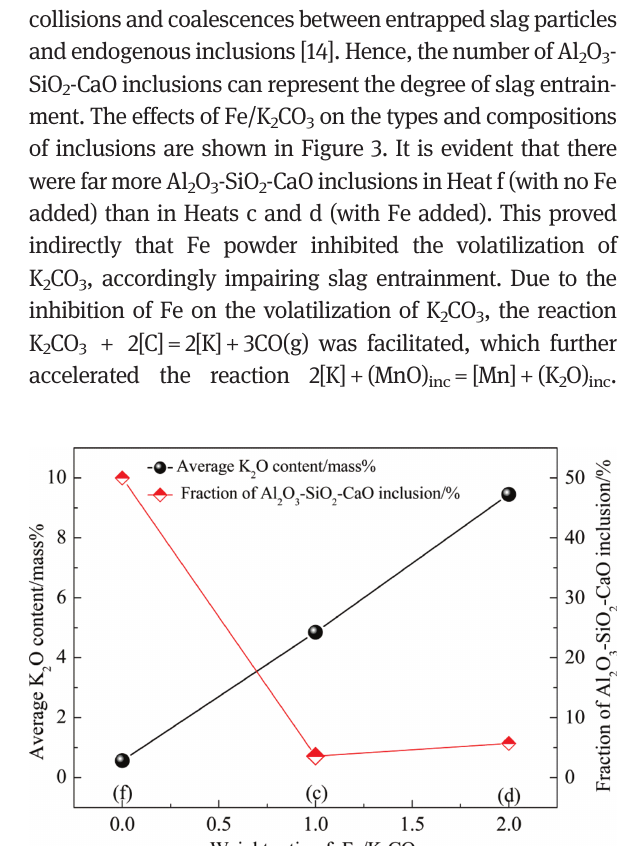
Figure 3: Effect of Fe/K 2 CO 3 on the types and compositions of inclusions.